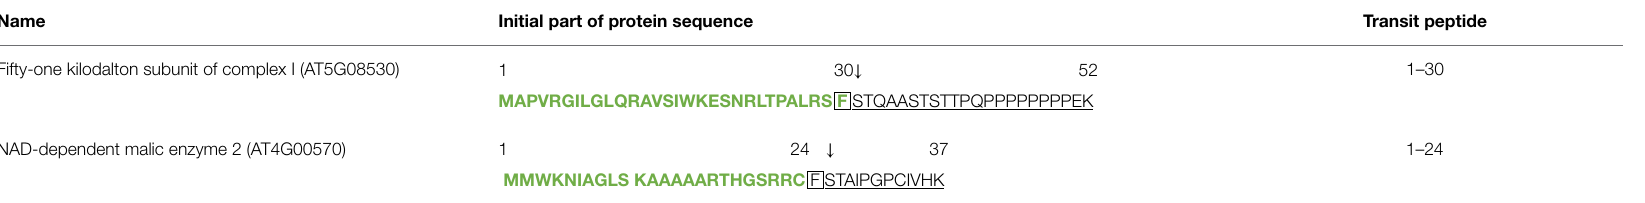
TABLE 2 | Re-localization of mitochondrial proteins to the